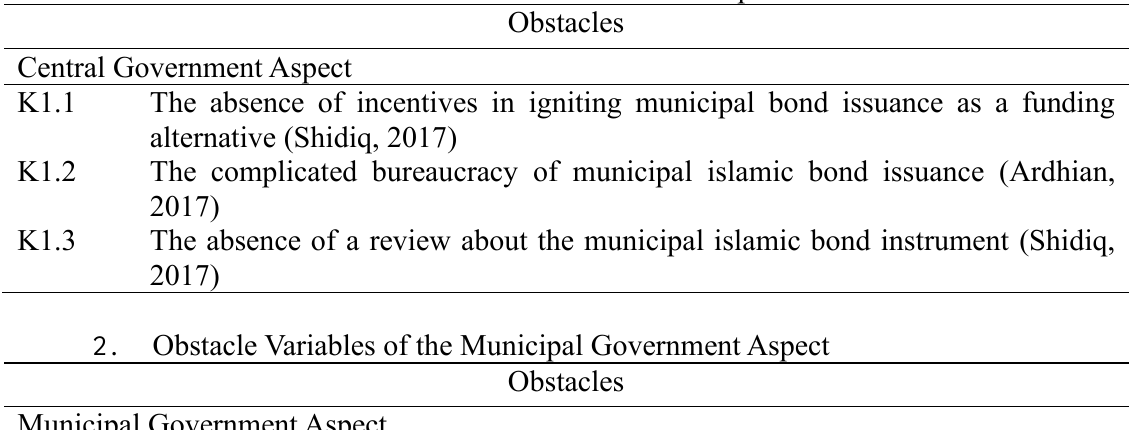
Table 2 Reduction Variables of Expert Validation